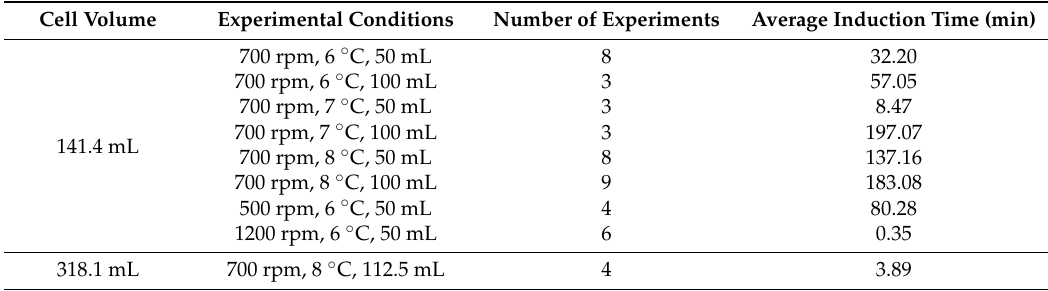
Table 3. Average induction time